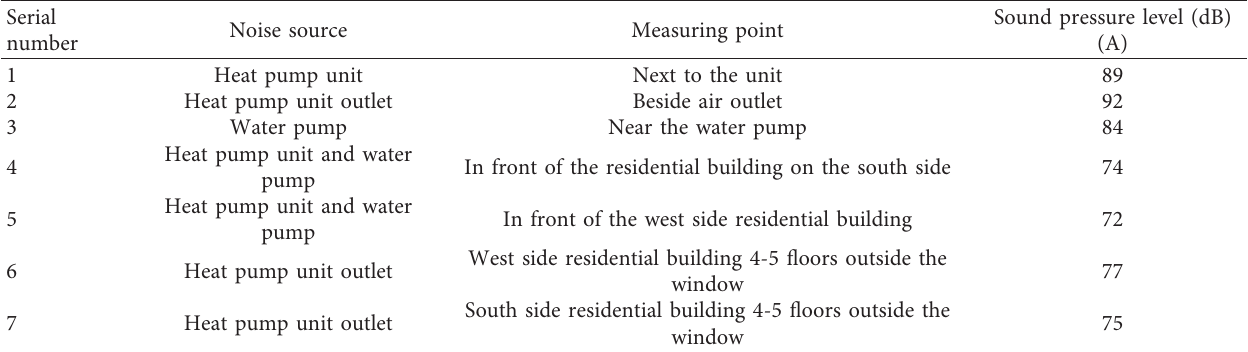
Figure 1: The air-cooled heat pump unit before noise reduction treatment: (a) left, photograph; (b) right, schematic diagram. Table 1: Sound pressure levels of the noise from heat pump units before noise modification.